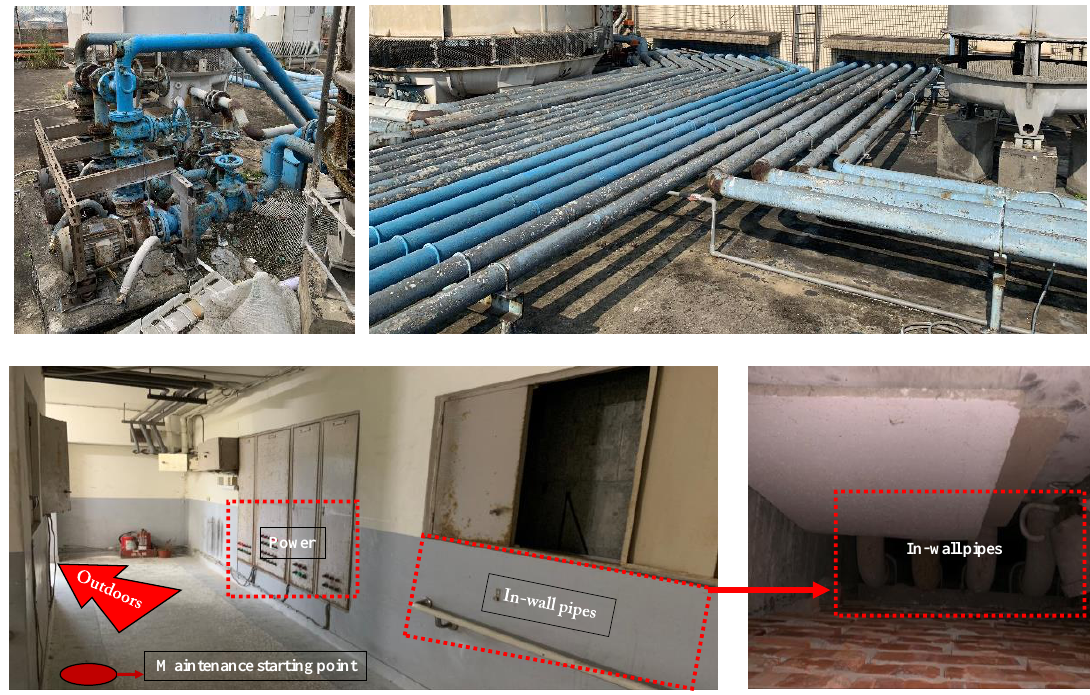
Figure 4. Photographs of outdoor (top) and indoor (bottom) layout to which BARMS was applied.